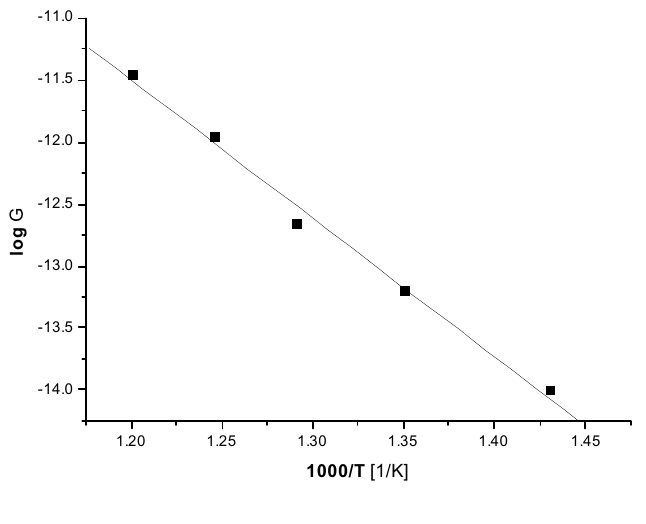
Figure 5. Conductance-temperature relationship of ZnGa